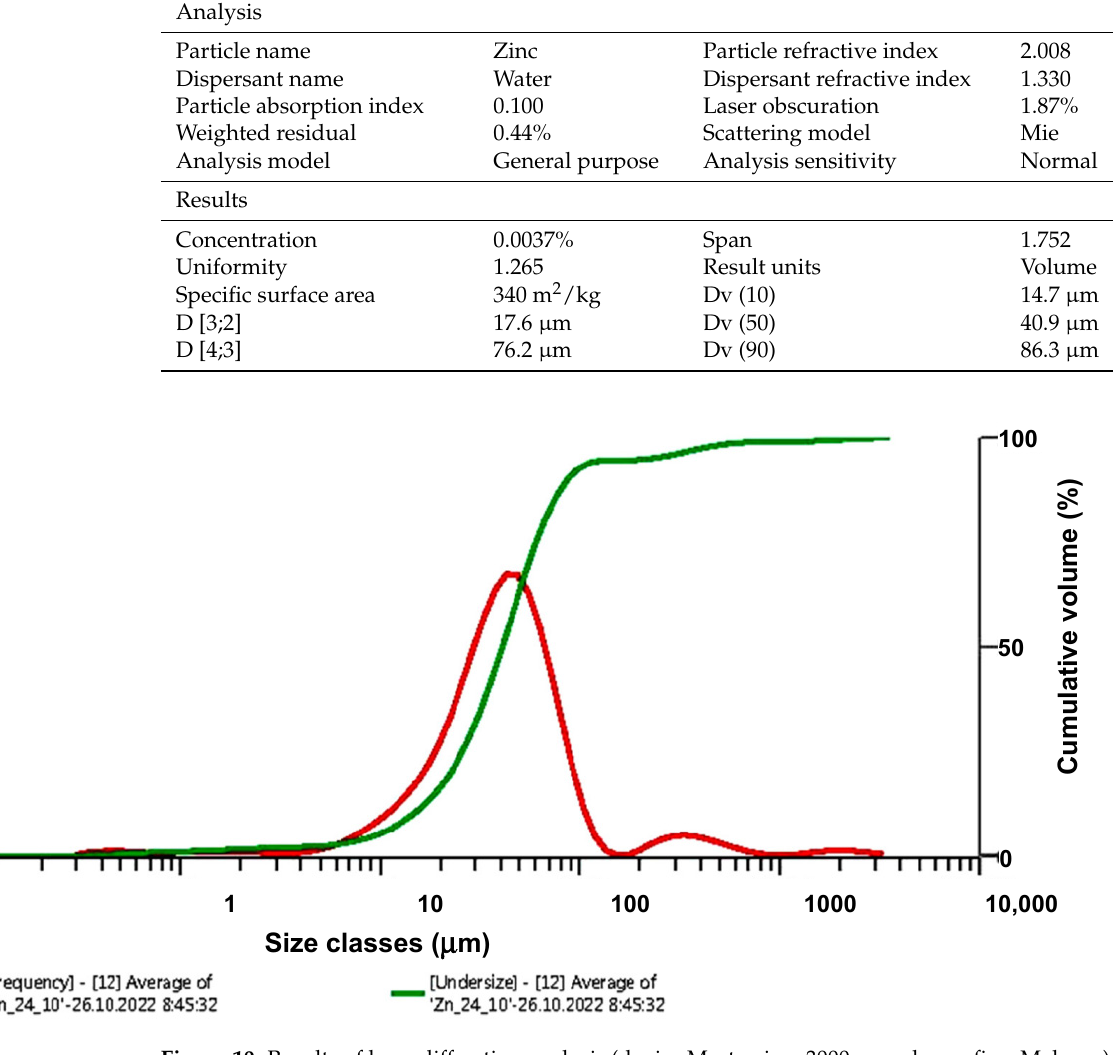
Figure 10. Results of laser diffraction analysis (device Mastersizer 3000—producer: firm Malvern) for Zn powder obtained at the electrolysis process. Radionuclide Co was used. Conditions are described in Table 20 above. Time of ultrasonic mixing: 60 min at 3000 rpm. Dv(50) = 40.9 µm.